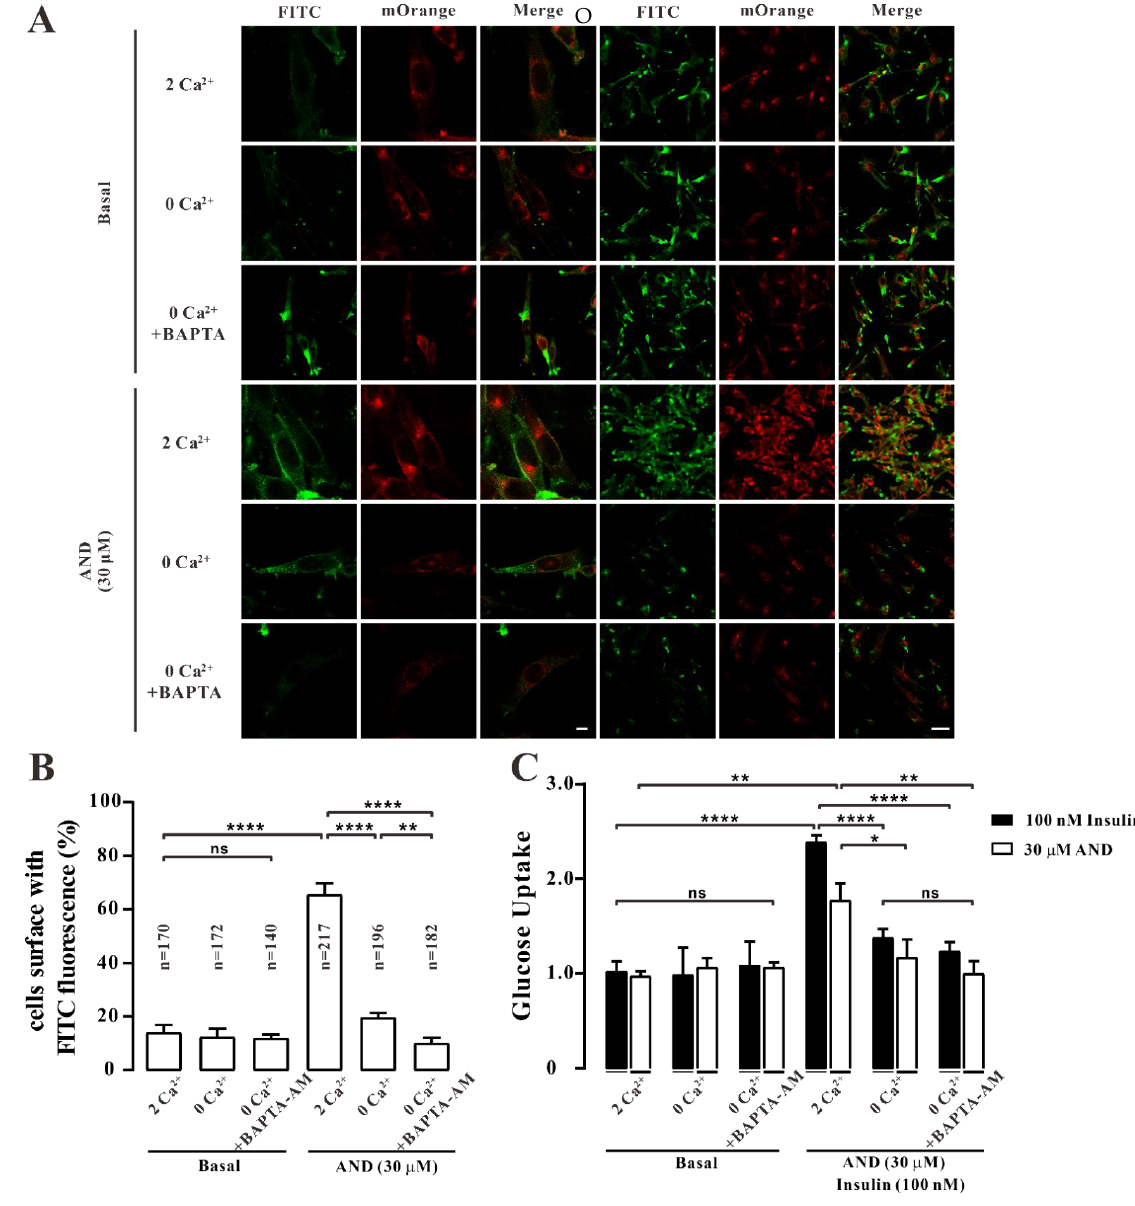
Figure 9. Translocation of GLUT4 and uptake of glucose induced by AND in L6 cells blocked by 0 mM extracellular Ca 2+ and 0 mM extracellular Ca 2+ + 10 µ M BAPTA-AM. ( A ) L6 cells were stimulated by AND under the conditions of 2 mM extracellular Ca 2+ , 0 mM extracellular Ca 2+ , and 0 mM extracellular Ca 2+ + 10 µ M BAPTA-AM. The distribution of red and green fluorescence in L6 cells was detected by confocal laser scanning microscopy. Scale bar: 10 µ m for single-cell images and 50 µ m for multi-cell images. ( B ) The number of GLUT4-mOrange-positive cells data represent the mean ± s.e.m. of values from three separate experiments, with between 200 and 300 cells examined in each experiment. ( C ) Uptake of glucose induced by insulin or AND in the three Ca 2+ buffering systems. The three groups on the left are the control group, and the three groups on the right represent glucose uptake after adding insulin and AND. The data represent the mean ± s.e.m. of values from three separate experiments. ns: p > 0.05; *: p < 0.05; **: p < 0.01; ****: p <